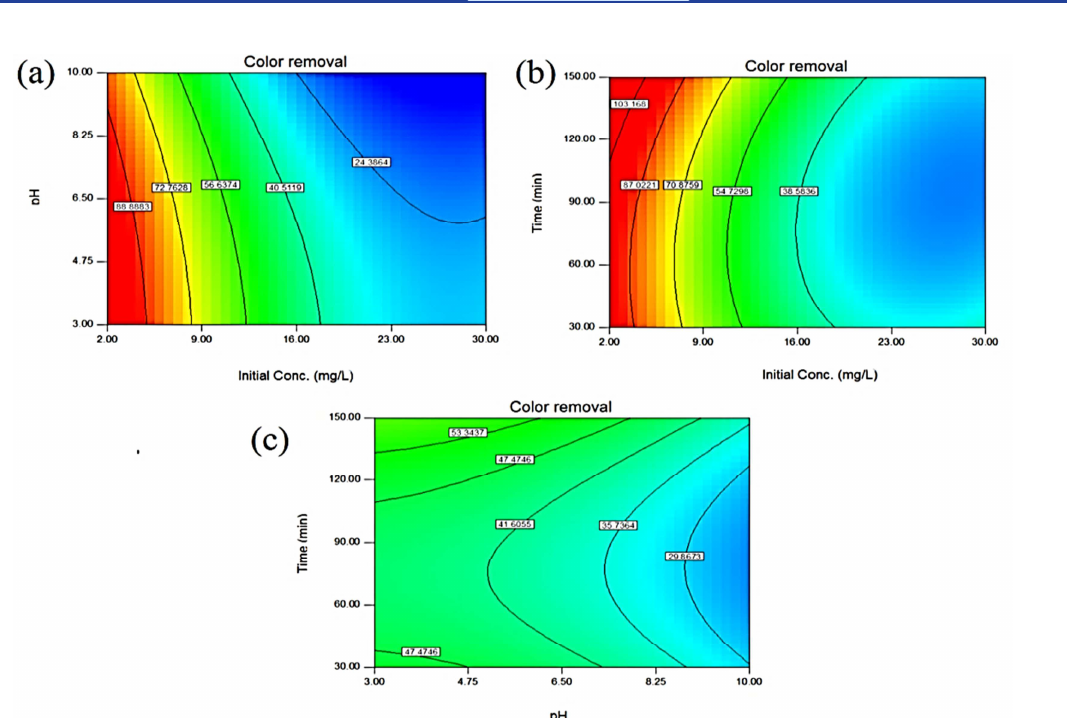
Figure 4. Two-dimensional plots for photocatalytic color